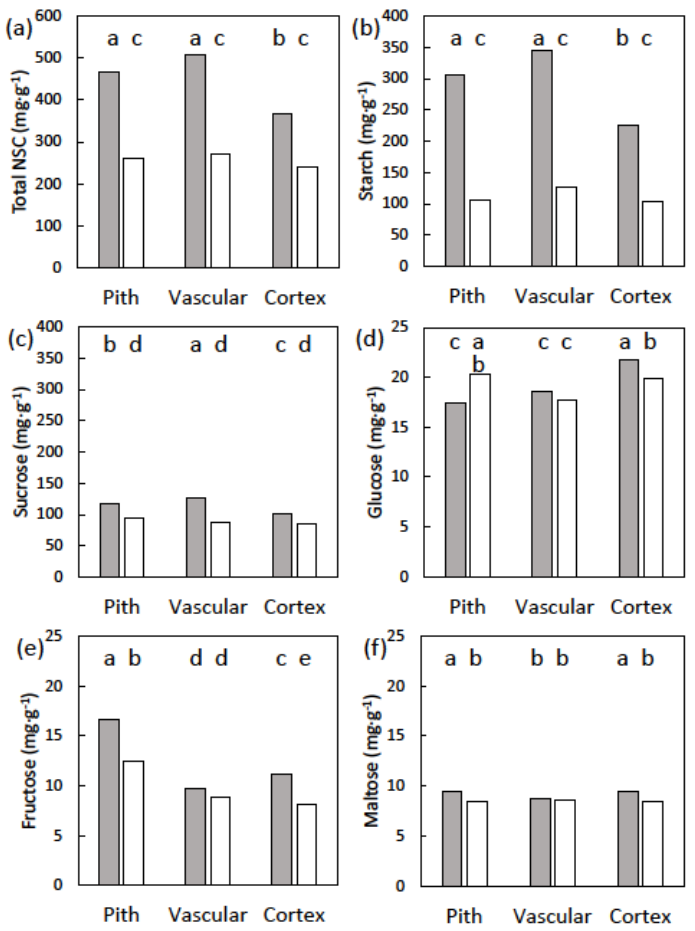
Figure 5. The non-structural carbohydrates (NSCs) of Cycas micronesica stem tissues among three radial tissues before (gray bars) and after (white bars) the construction of synchronized leaf flush. Defoliated trees had leaves removed prior to emergence of the new leaves. ( a ) Total NSC; ( b ) starch; ( c ) sucrose ( d ) glucose; ( e ) fructose; and ( f ) maltose. Bars with same letters are not different for NSCs with significant time × tissue effects.